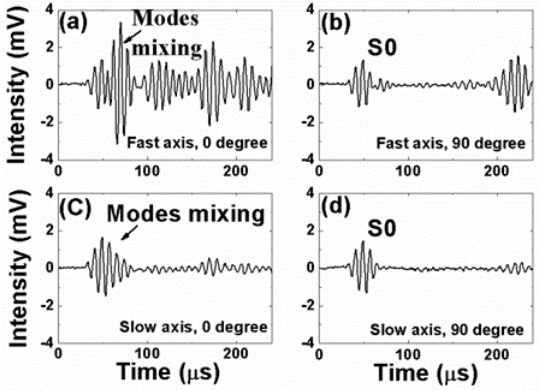
Figure 7. Responses of the Polarization-maintaining Fiber Bragg grating under 90 kHz actuation to ( a ) 0-degree excitation and fast-axis detection; ( b ) 90-degree excitation and fast-axis detection; ( c ) 0-degree excitation and slow-axis detection; and ( d ) 90-degree excitation and slow-axis detection.